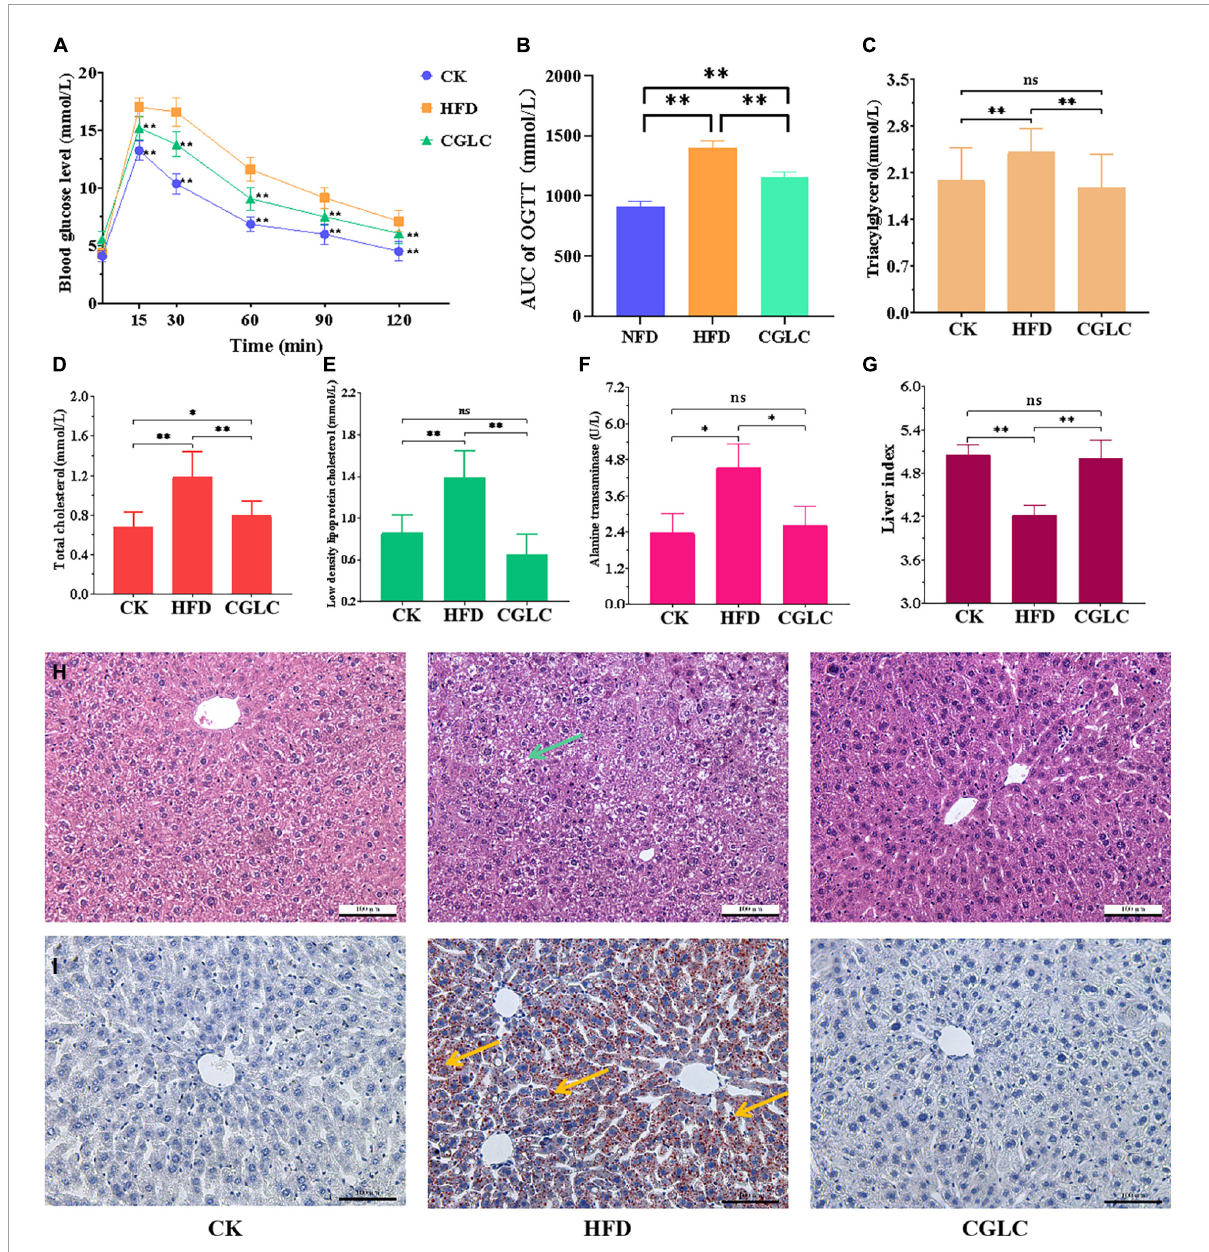
FIGURE2 Effects of CGLC on blood glucose, serum lipid levels, and liver tissue. (A) OGGT. (B) Area under the curve. (C) TG levels. (D) TC levels. (E) LDL-C levels. (F) Alanine transaminase activity. (G) Liver index. Pathological section observation of liver tissue stained by HE (H) and oil red O (I) , respectively (scale bar 100 µ m, 200 × ). AUC, area under the curve; green arrow, tiny round fat vacuoles; blue arrows, lipid droplets. ns, no significant difference; ∗ , significant difference ( P < 0.05); ∗∗ , highly significant difference ( P <